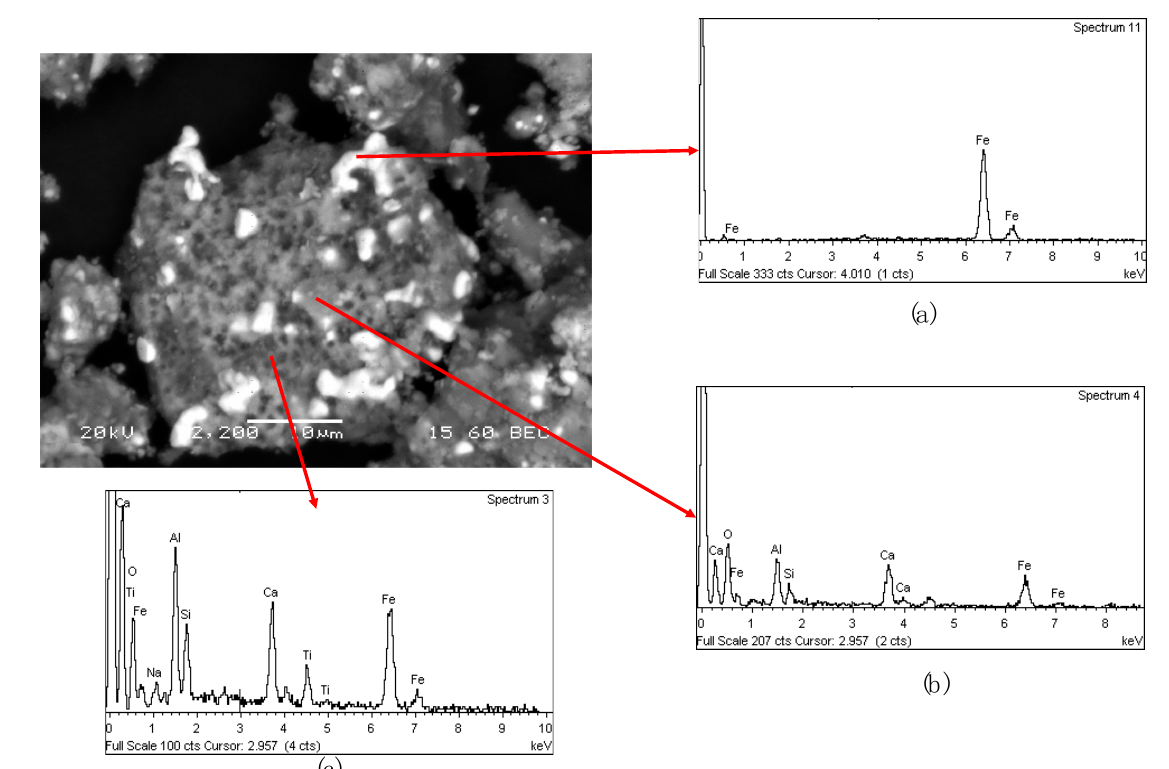
Figure 15. Back electron scattering mode SEM-EDS analysis of NM fraction: ( a ) small metallic iron particles ( b ) light gray particles (calcium aluminium silicon oxide) ( c ) particles composed by all the cinder constituents (Na, Al, Ca, Si, Ti and Fe). Furthermore, the NM fraction was analyzed by employing a secondary electron im- aging mode to comprehend the existing different mineralogical phases (Figure 16).